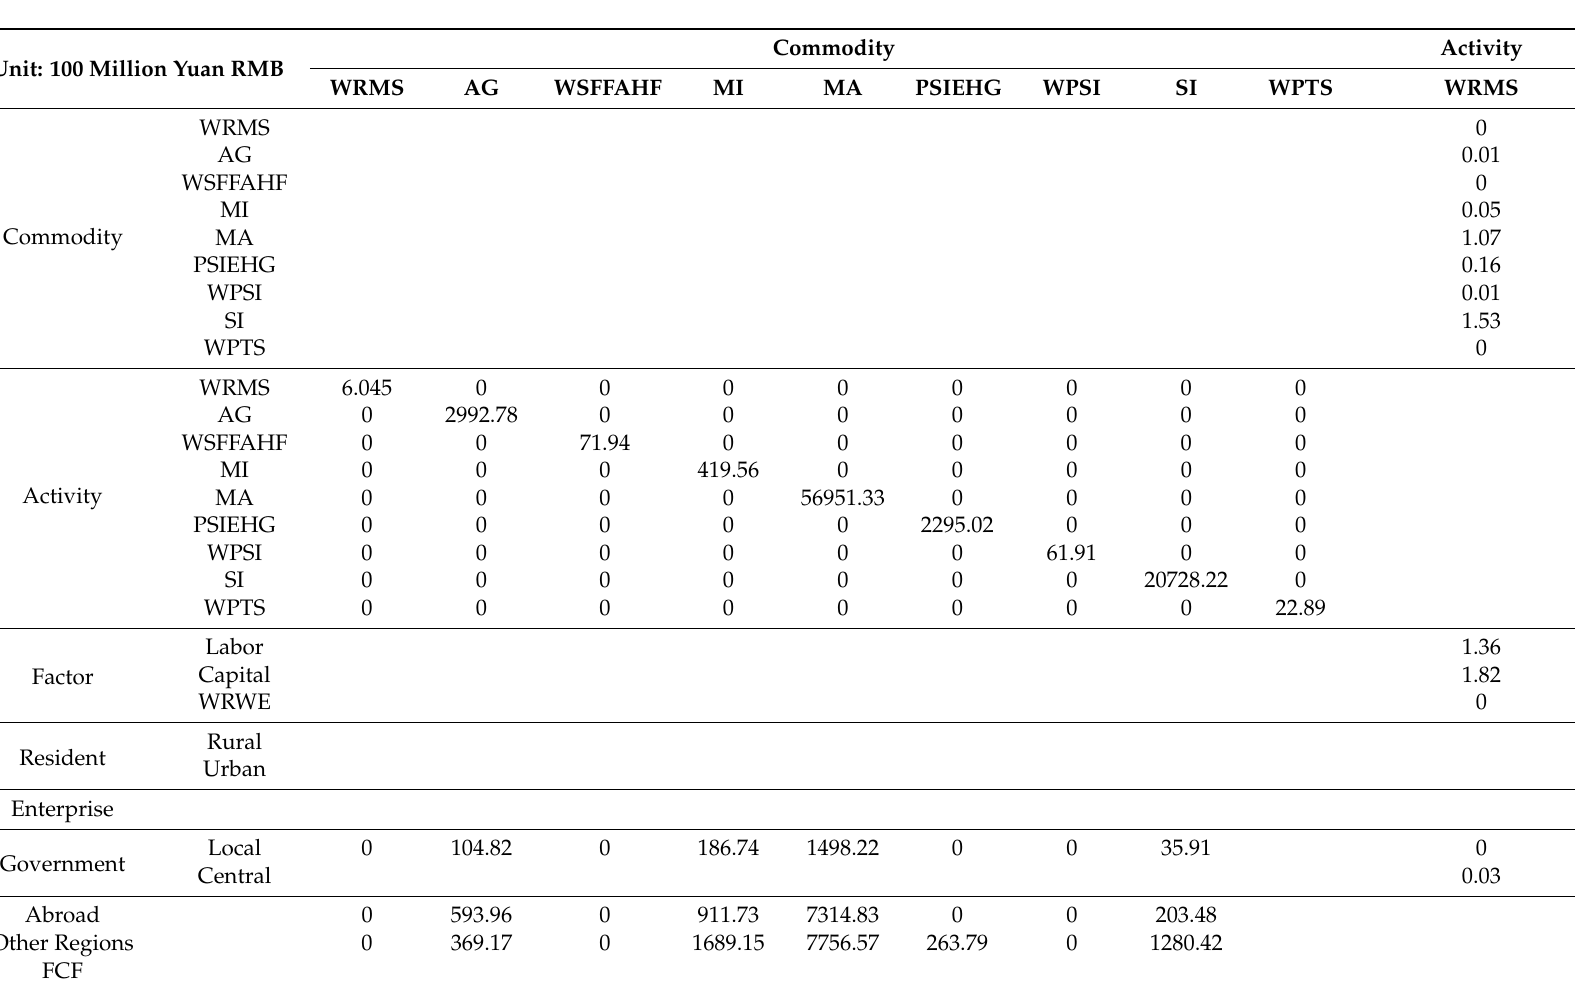
Table 1. Water Resources and Water Environment Social Accounting Matrix (WRWESAM) of Jiangsu province